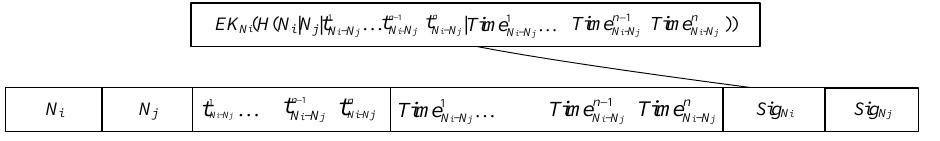
Figure 5. Encounter ticket.